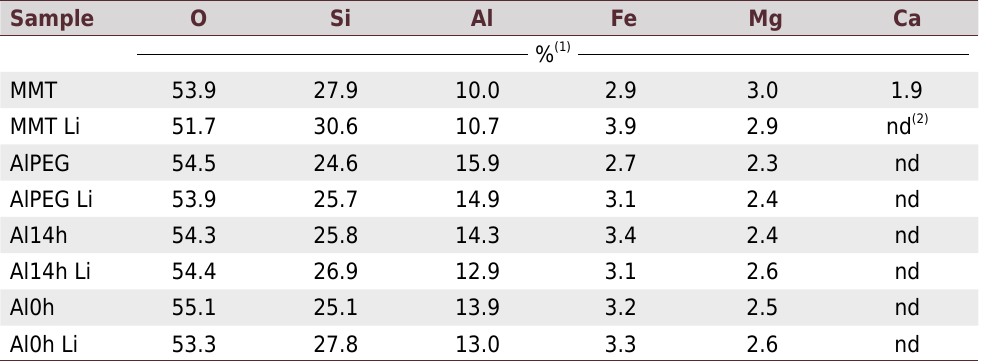
Table 2. Results of chemical composition (EDS) of the samples (mean values of analysis of 15